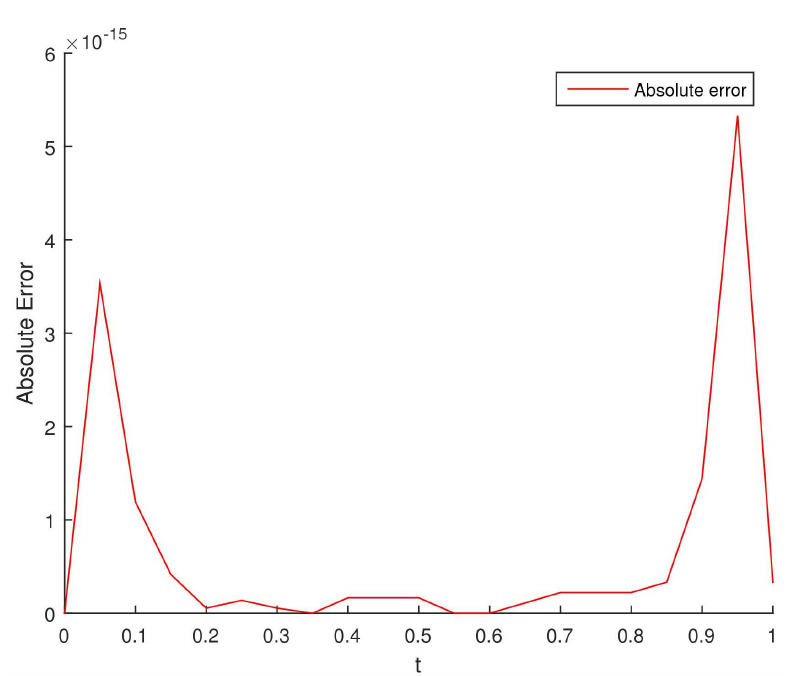
Figure 18. The absolute error of Example 6 for t ∈ [ 0,1 ]